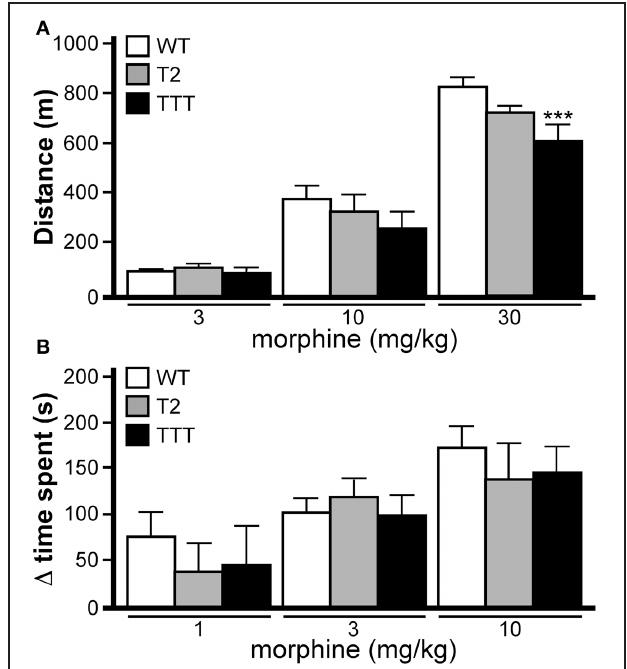
FIGURE 6 | Opioid-induced motor activity and reward in mice lacking Trek channels. (A) Morphine-induced locomotor activity was measured during a 60min session in wild-type (WT, white), Trek2 − / − (T2, gray), and Trek1/2 / Traak − / − (TTT, black) mice ( n = 12–16 per group). Significant main effects of morphine dose [ F ( 3 , 144 ) = 250 . 6, P < 0 . 0001] and genotype [ F ( 2 , 144 ) = 4 . 6, P < 0 . 05] were observed, as well as a dose x genotype interaction [ F ( 6 , 114 ) = 2 . 5, P < 0 . 05]. While no significant differences were observed between genotypes at either the 3mg/kg or 10mg/kg doses, Trek1/2 / Traak − / − showed a slightly blunted response to 30mg/kg morphine as compared to wild-type controls. ( B) Morphine-induced CPP was measured in wild-type ( n = 10–15/dose), Trek2 − / − ( n = 7–9/dose), and Trek1/2 / Traak − / − ( n = 6–7/dose) mice using a standard CPP test. While a significant main effect of morphine dose was observed [ F ( 2 , 73 ) = 9 . 0, P < 0 . 001], there was no main effect of genotype [ F ( 2 , 73 ) = 0 . 5, P = 0 . 59] or dose x genotype interaction [ F ( 4 , 73 ) = 0 . 32, P = 0 . 86]. No genotype-dependent differences were observed in morphine-induced CPP, as measured by calculating the change in time spent ( (cid:2) time spent) in the drug-paired side from Day 1–5. In panels A and B , only within-dose pair-wise comparisons are highlighted. Symbols: ∗∗∗ P < 0 . 01, vs.